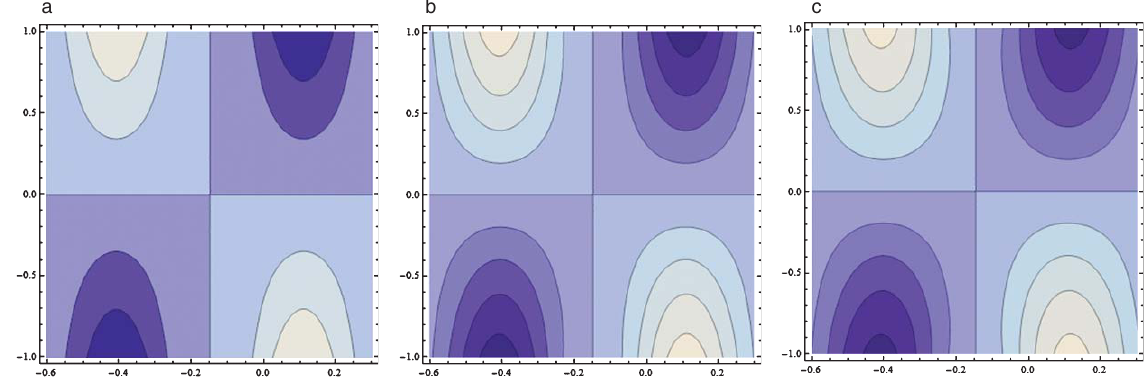
Fig. 5. Variation of M on ψ for E 1 = 0 . 5 , E 2 = 0 . 2 , E 3 = 0 . 1 , E 4 = 0 . 05 , E 5 = 0 . 3 , (cid:11) = 0 . 2 , t = 0 . 1 , α = 1 . 5 , β = 0 . 02 , when (a): M = 2 (b): M = 3 (c): M = 4.